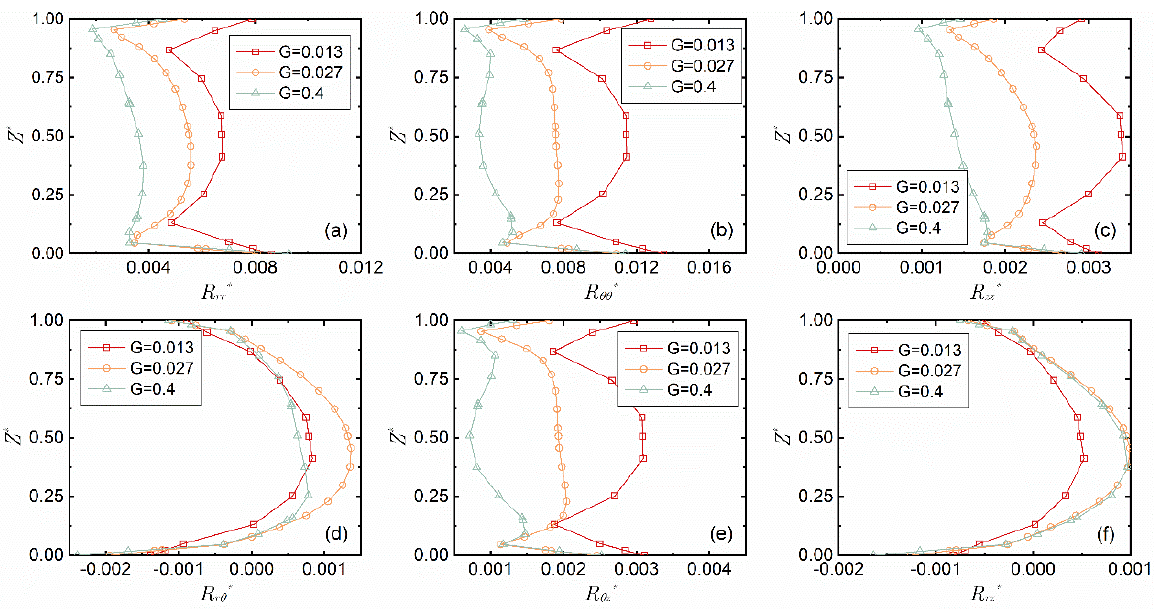
Figure 7. Change of the six components of the Reynolds stress tensor ( a – f ) with the gap-to-diameter ratio G when Re = 7.02 × 10 4 and r * = 0.8.